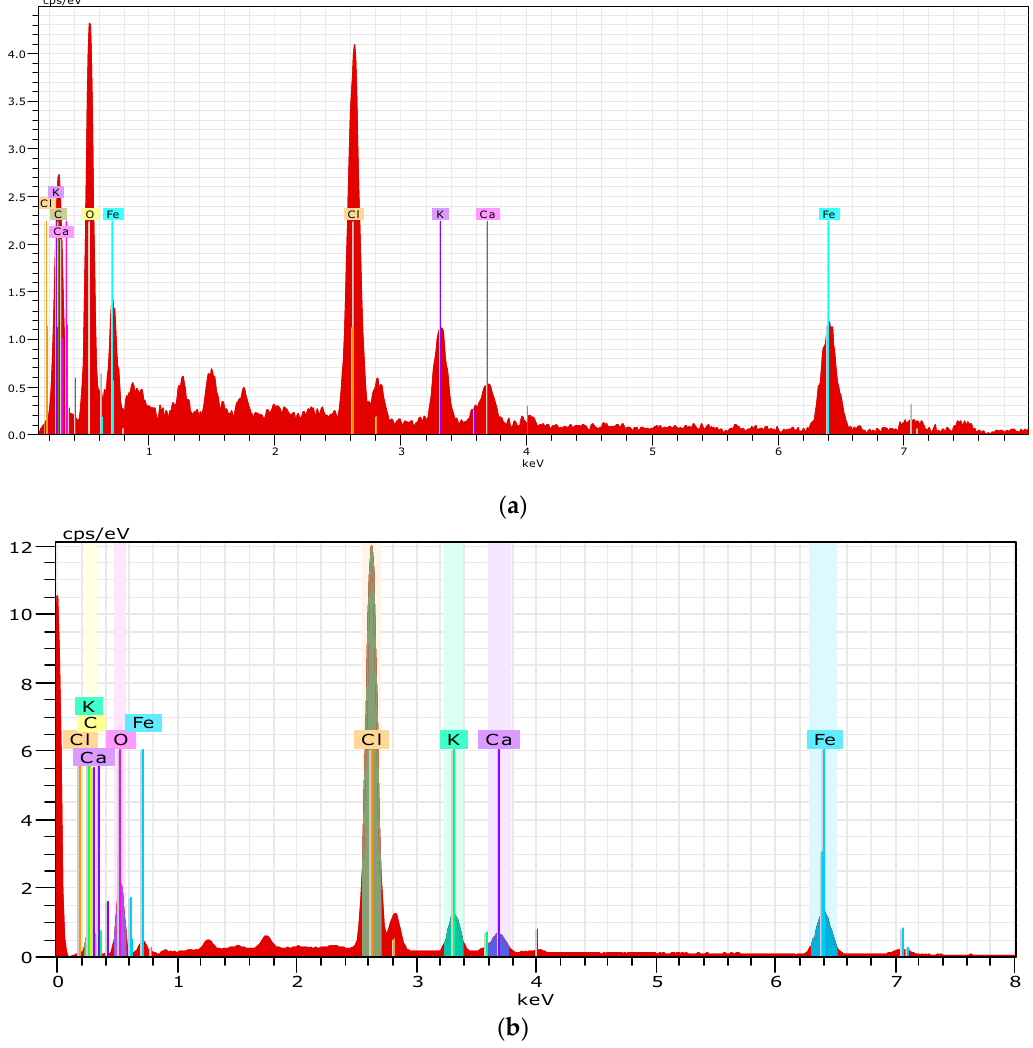
Figure 2. EDS atomic mapping of ( a ) OAK-nZVI and ( b )